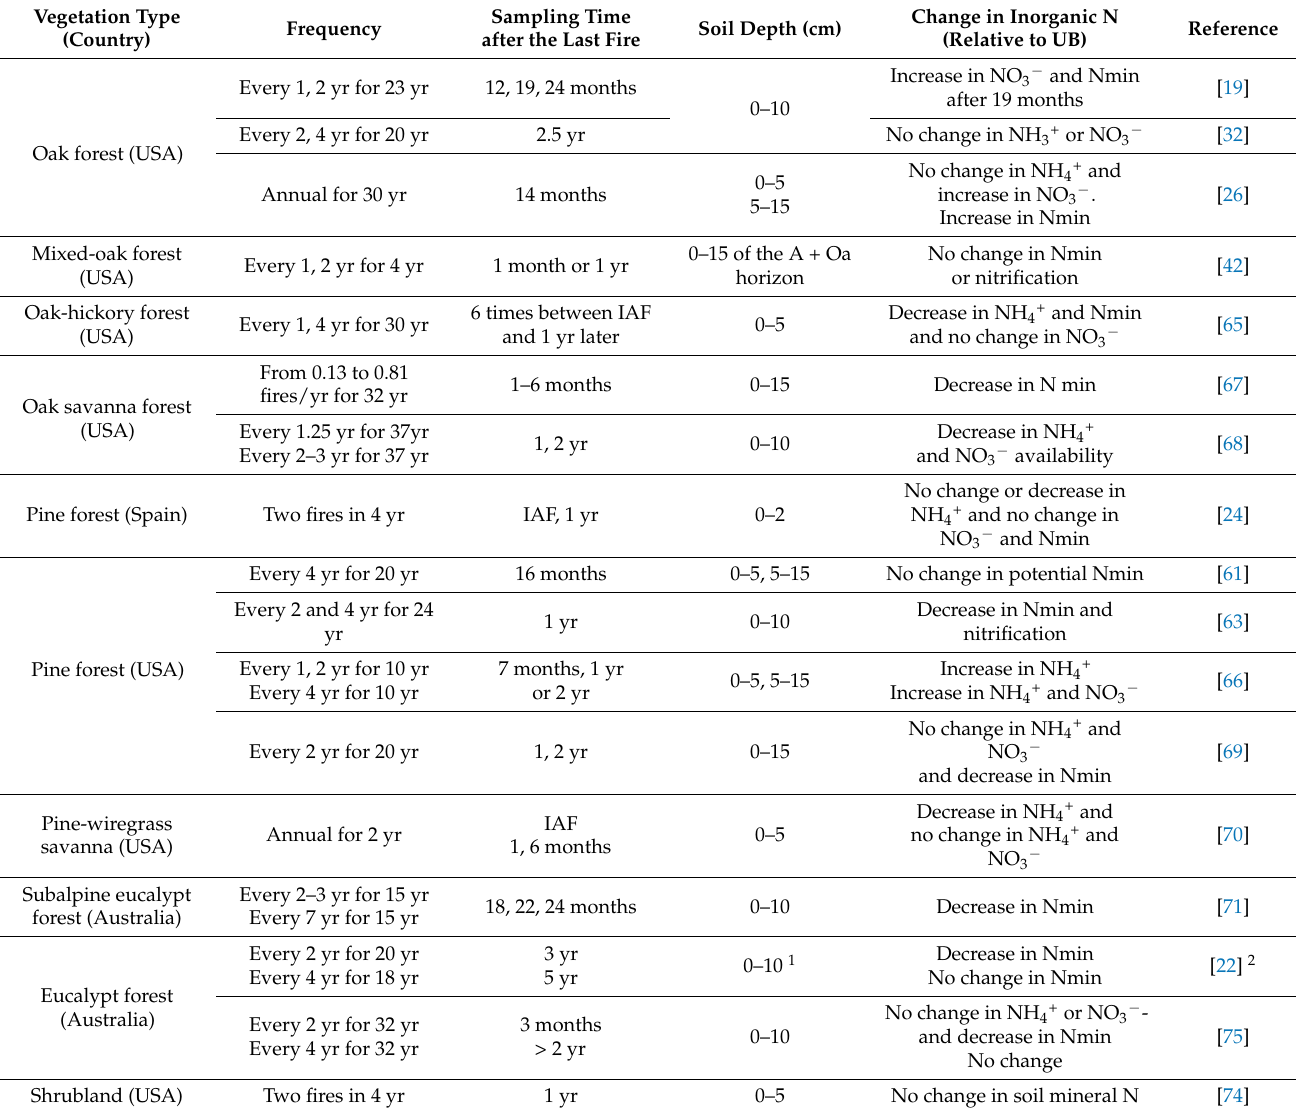
Table 4. Studies including the effects of repeated prescribed fires on inorganic N (concentration of extractable N-NH 4+ and N-NO 3 − ) and N mineralization (Nmin). UB: unburned soil; yr: year; IAF: immediately after